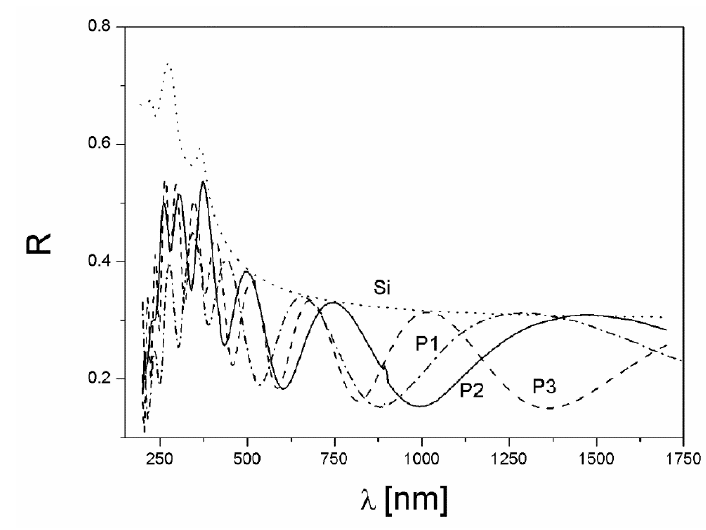
Figure 6. Total reflectance on porous SiO 2 films on Si substrate, P1, P2, and P3 are marked as dotted, dashed, solid, and chained lines, respectively.